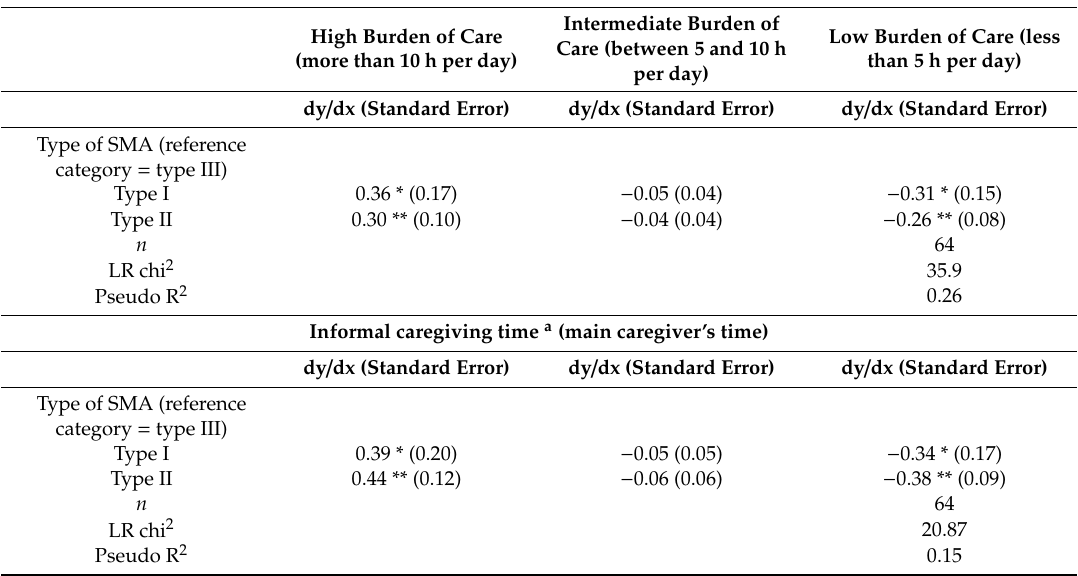
Table 3. Results of the statistical analysis (marginal e ff ects) of the time of informal care of patients with